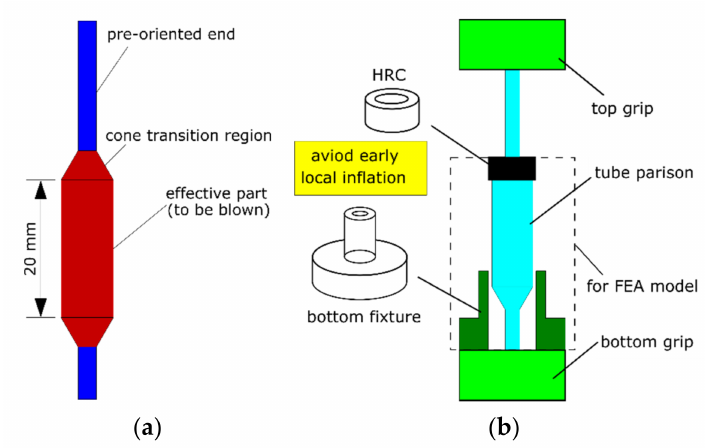
Figure 2. Free stretch blow test: ( a ) tube parison, ( b ) experimental